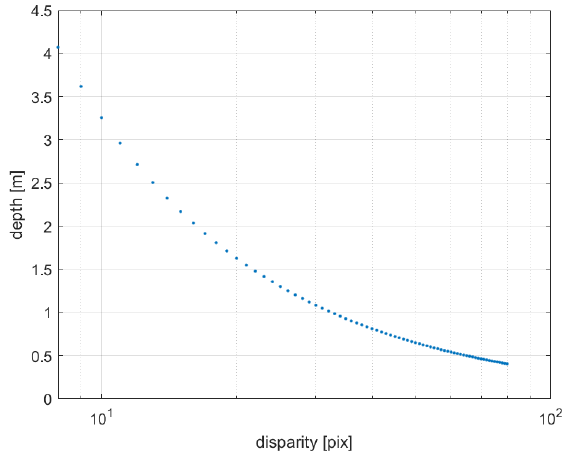
Figure 5. Estimated depth as a function of the disparity computed at pixel resolution